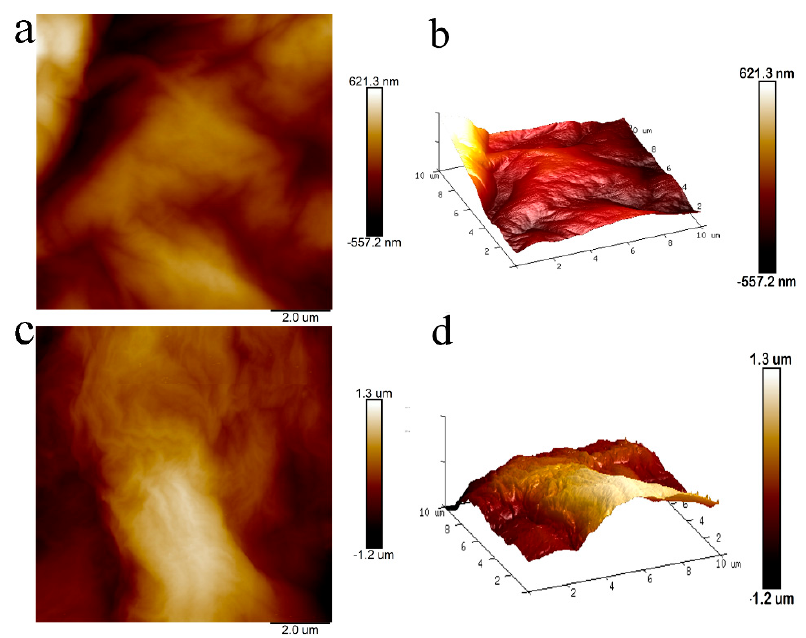
Figure 9. Two-dimensional and three-dimensional AFM images of GO membrane ( a,b ) and GO/EG membrane ( c,d ).